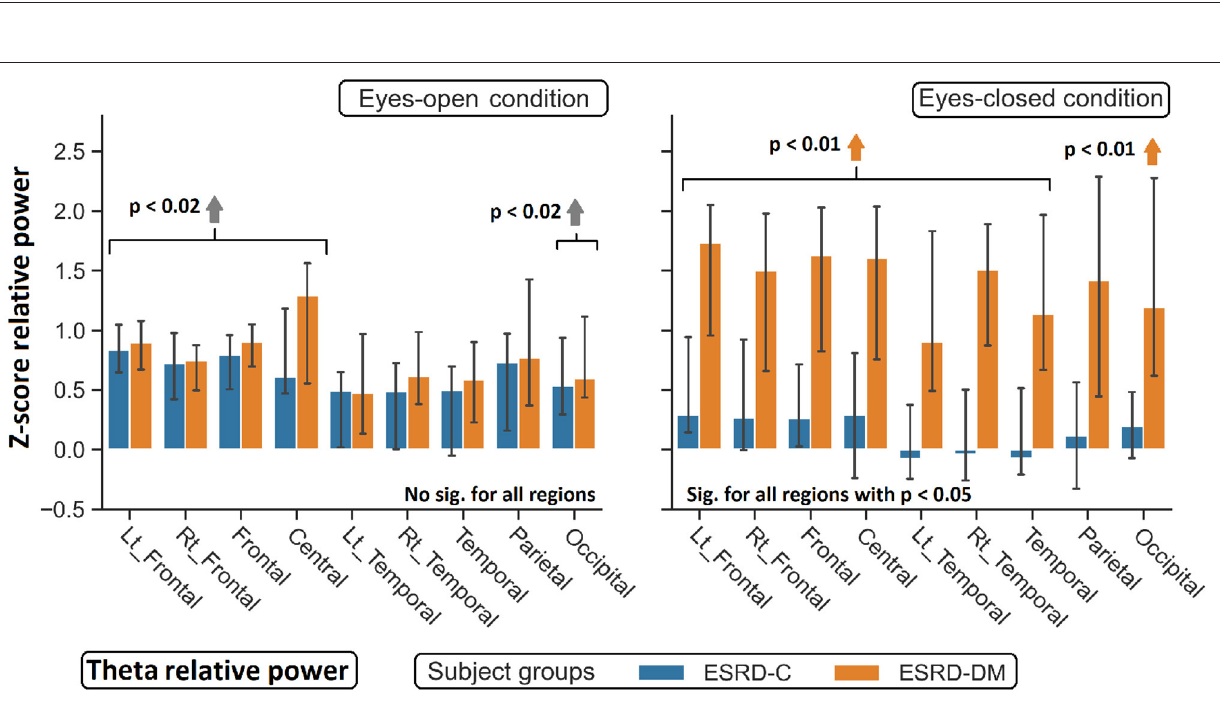
Frontiers in Human Neuroscience | www.frontiersin.org